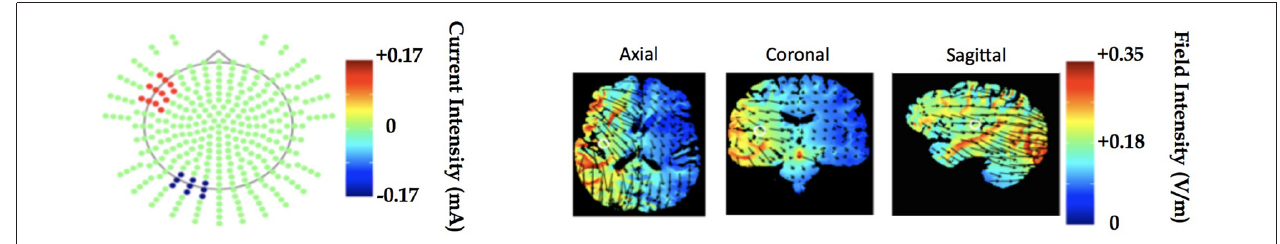
FIGURE 3 | Electrode montage and underlying left hemisphere cortical regions to be stimulated modeled in Soterix transcranial direct current stimulation (tDCS)-Explore™. The model demonstrates current delivery to the F7 and O1 locations results in field intensity increase in regions associated with language